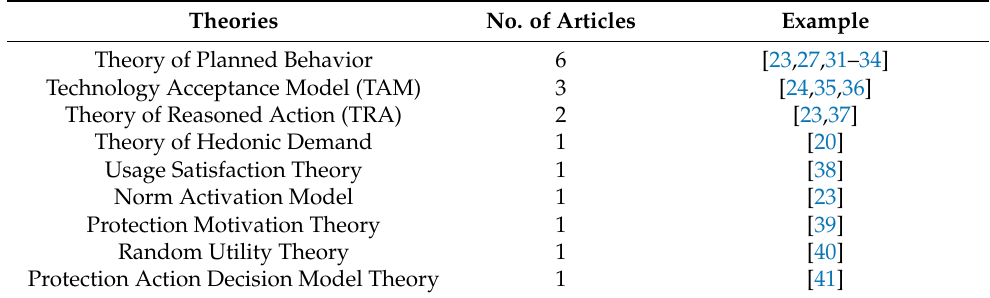
Table 7. Theories used in the reviewed studies on consumer adoption of electric vehicles.